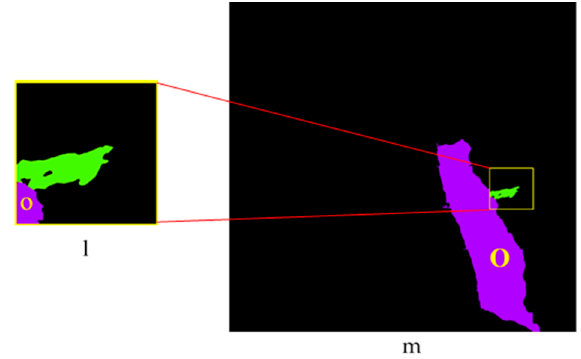
Figure 8. The weight focus matrix of each time.